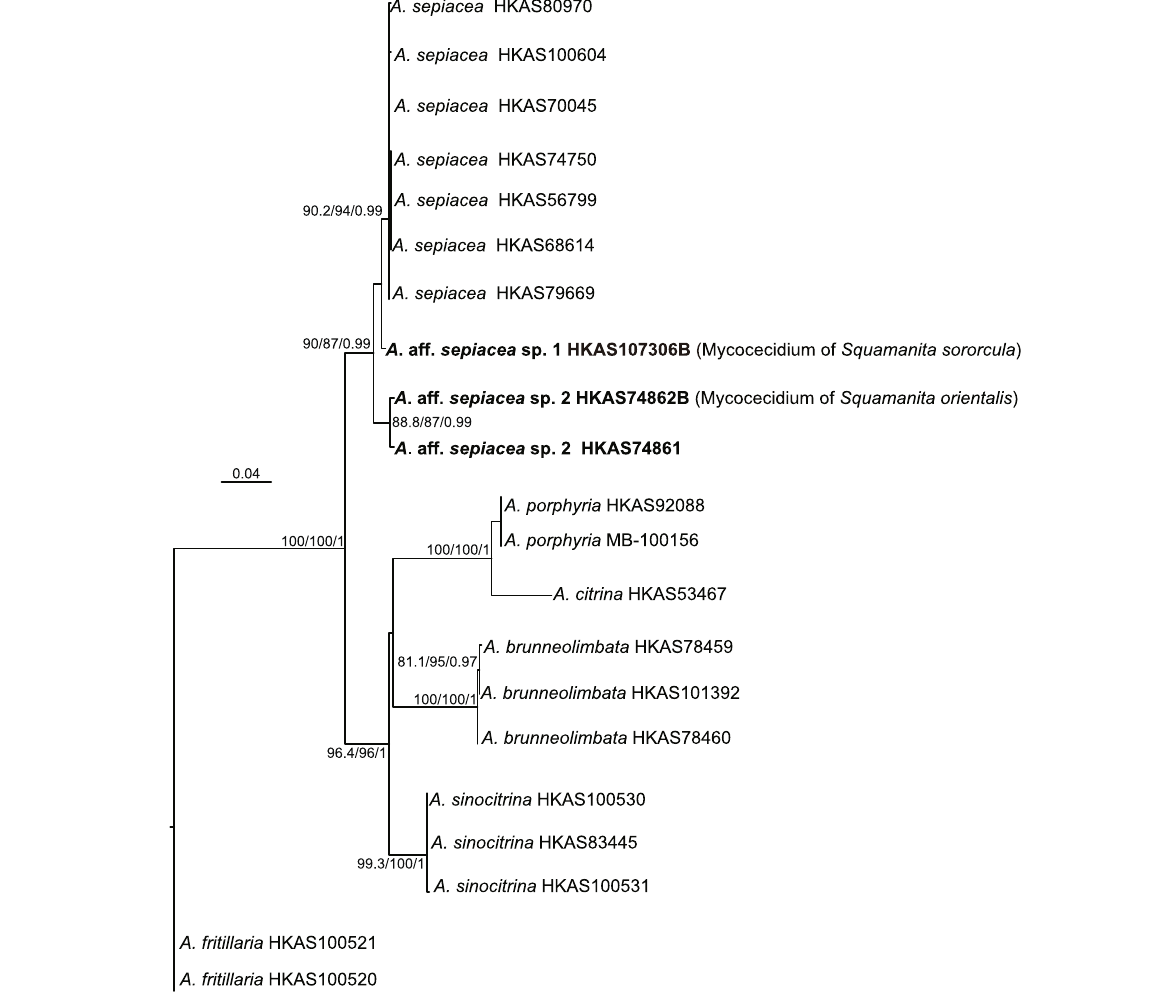
Fig. 5 Maximum-Likelihood (ML) phylogenetic tree inferred from the ITS dataset for detecting the phylogenetic relationships of the mycocecidia (hosts) of Squamanita orientalis , S. sororcula and one specimen (HKAS74861) of Amanita sepiacea that was collected nearby S. orientalis (these three specimens are highlighted in boldface), with SH-aLRT (left), ultrafast bootstrap (UFB) (middle), and PPs values (right) near by the corresponding node. Only one of SH-aLRT > 80 or UFB > 95 for ML and PPs > 0.90 for BI are indicated along branches